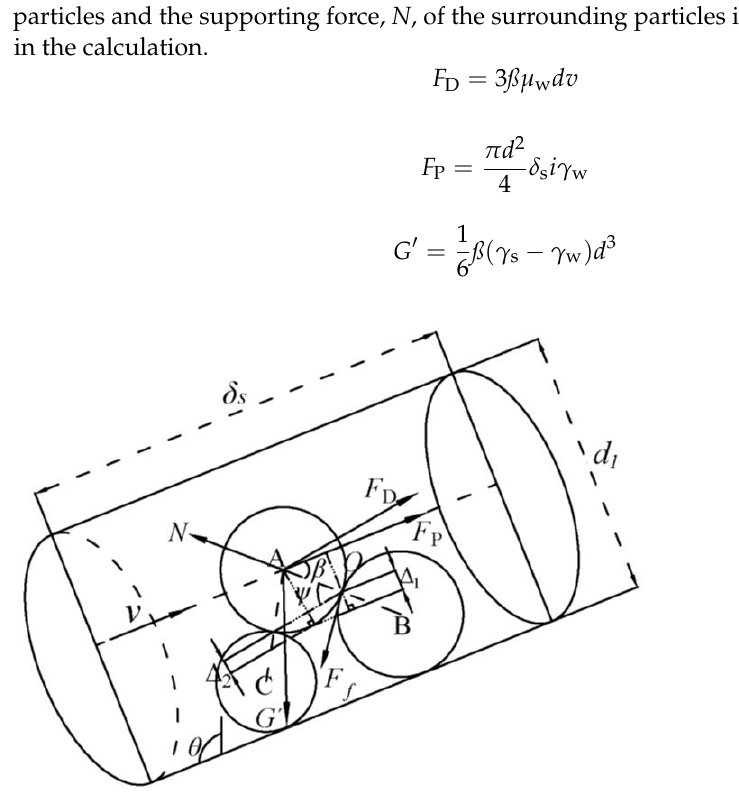
Figure 1. Schematic diagram of the forces acting on the